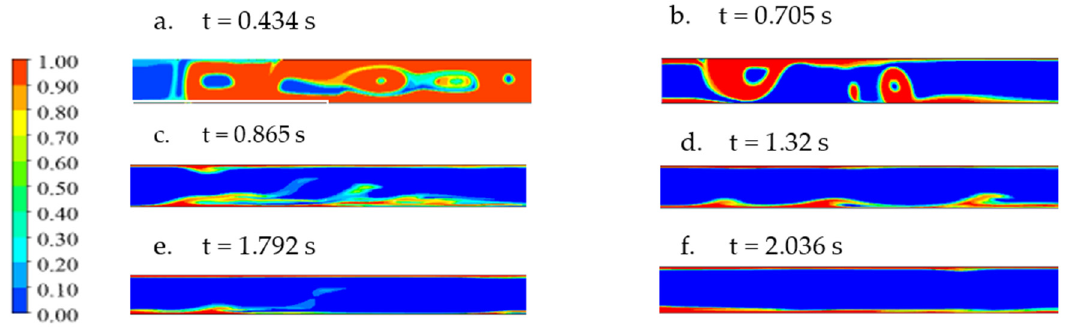
Figure 10. Contours of water volume of fraction (VOF) distribution illustrating flow pattern changes from slug flow to full annular flow: ( a ) bubbly/slug flow; ( b ) slug flow; ( c – e ) wavy annular flows; ( f ) full annular flow, respectively. The ‘red’ colour represents the ‘liquid (water) film’ and the ‘blue’ colour represents the ‘air’. Other colours represent a mixture of air/water.